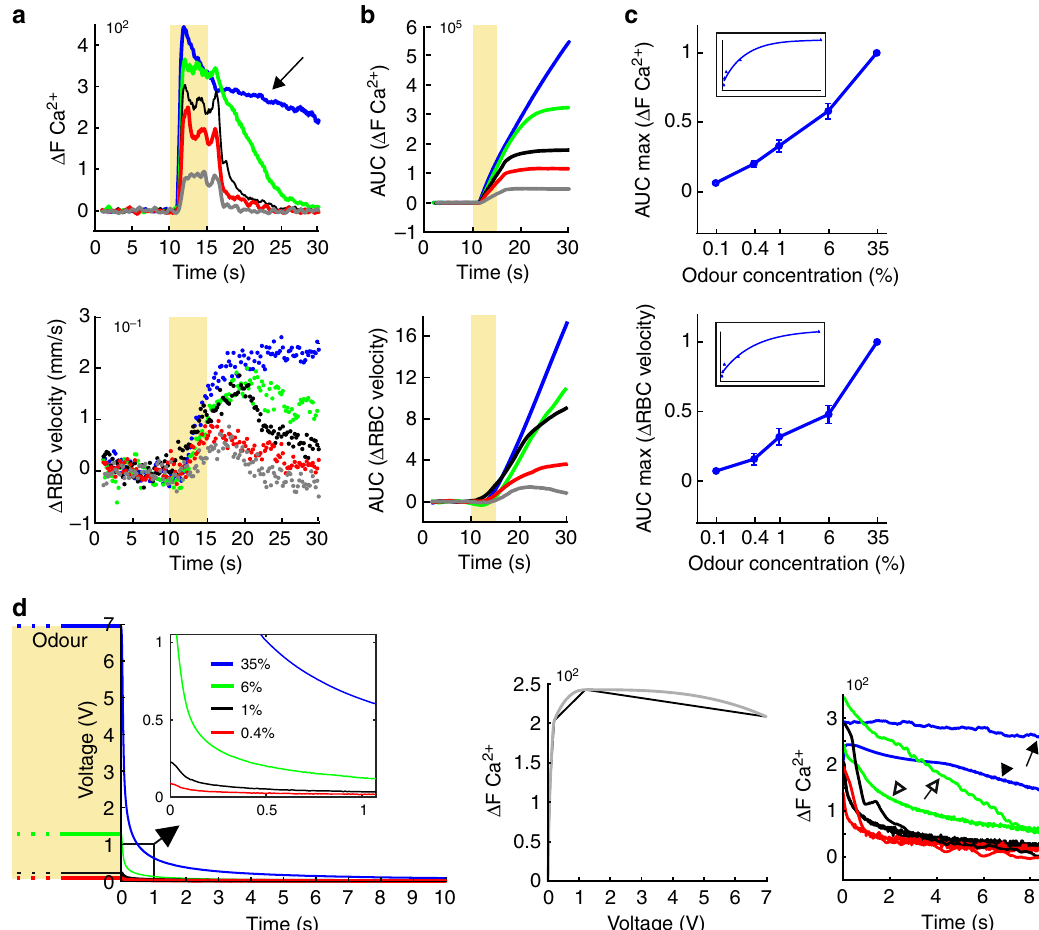
Fig. 3 Concentration dependency of neuronal and capillary blood fl ow responses to odour. a Neuronal (top) and RBC velocity (bottom) responses to odour at increasing concentration. Each trace is an average of three trials. Note that at high odour concentration (arrow) the recovery of Ca 2 + to baseline is delayed. Baseline RBC velocity: 0.25 mm/s. b Plots of the signal integral vs. time (area under the curve, AUC) for Ca 2 + and RBC velocity responses. c Semi- log plots (AUC maxima) of summarized data for fi ve mice. Values are normalized to the maximum value (35% odour). Data presented as mean ± SEM. Insets: exponential fi ts of the data with coef fi cients different from zero (CL > 95%). Baseline RBC velocities (mean ± SEM: 0.45 ± 0.19 mm/s). d At high odour concentration, enhanced neuronal responses are caused by delayed wash out across the 6 m delivery tubing. Left: time course of the odour measured in voltage ( V ) with a miniPID. The inset illustrates that when applied at 35%, the ET concentration 1 s after the offset remains important. Middle: plot of experimental Δ Ca 2 + values (black trace) taken at the end of the odour puff as a function of the miniPID voltage steps. A fi tted curve with interpolated values is shown in grey. Right: traces of real and modelled Δ Ca 2 + decays as a function of time. Arrows point to real decays and arrowheads at model decays for 35 and 6% odours (blue and green traces, respectively). The persistence of odour at the end of the puff delivery accounts for a very signi fi cant proportion of the neuronal